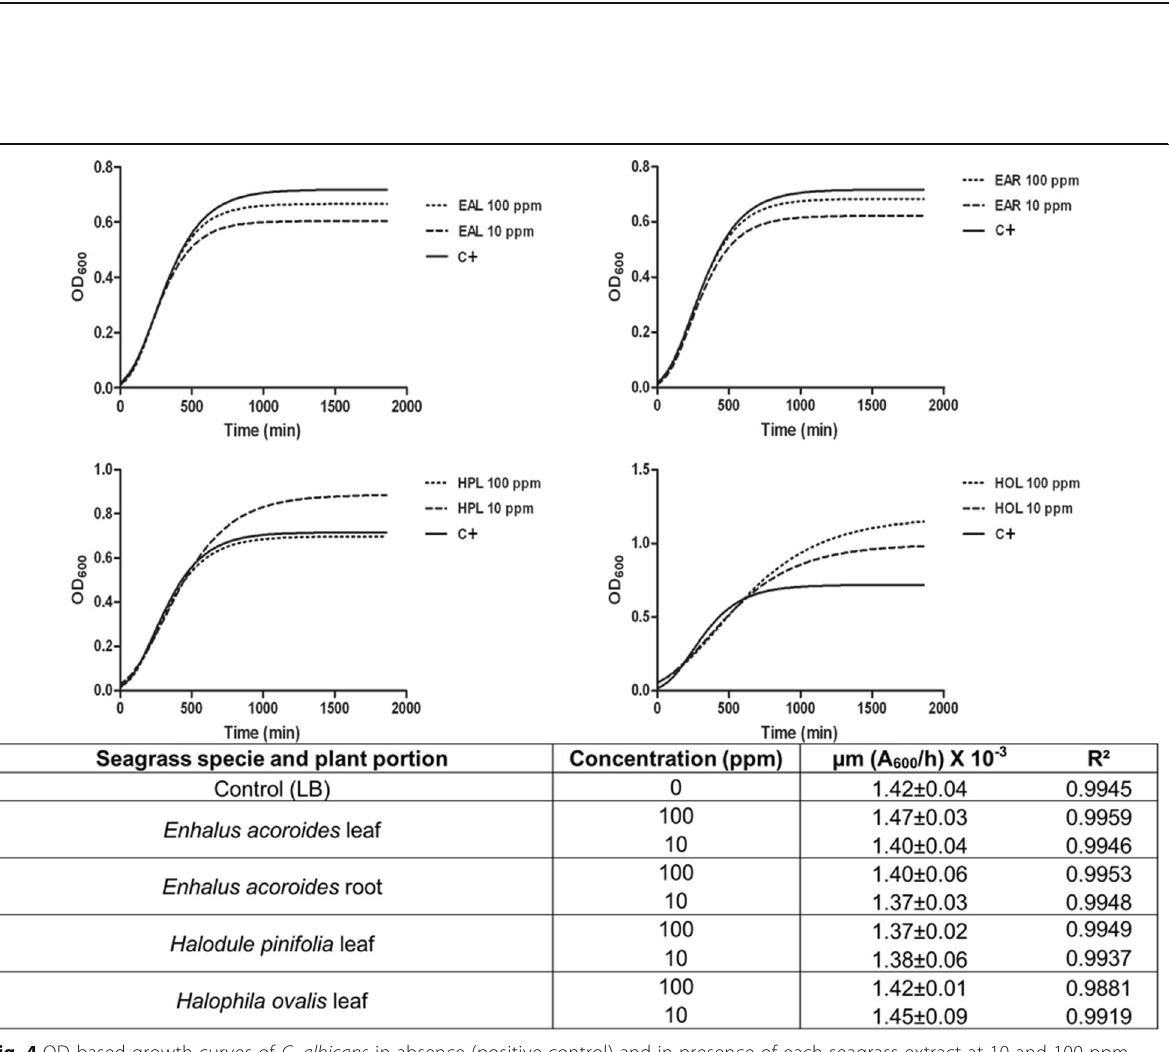
Fig. 4 OD-based growth curves of C. albicans in absence (positive control) and in presence of each seagrass extract at 10 and 100 ppm. Maximum specific growth rate ( μ m ) and the goodness of fit (R 2 ) obtained by the Gompertz model. Data represent the mean ± SDs of three independent measurements. Means reported showed no statistically significant differences between the positive control and treated samples (Tukey ’ s HSD, p ≥ 0.05). (EAL = Enhalus acoroides leaf; EAR = Enhalus acoroides root; HPL = Halodule pinifolia leaf; HOL = Halophila ovalis leaf; C + = Positive